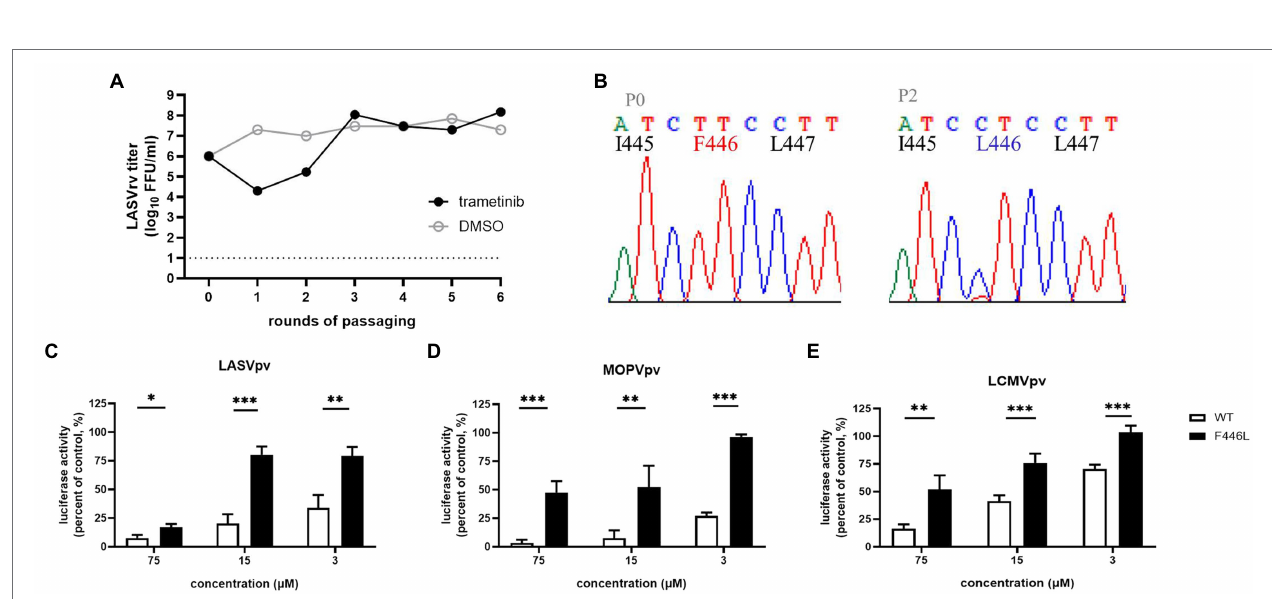
FIGURE 5 | Broad-spectrum antiviral activity of trametinib. (A–H) The inhibition of trametinib against the infection of the pseudotype of mammarenaviruses. (I) Inhibition of trametinib against authentic lymphocytic choriomeningitis virus (LCMV) infection. Vero cells were incubated with trametinib for 1 h, and LCMV Cl 13 (MOI, 0.01) was added into the cells 1 h. Then, the supernatants were replaced with medium containing trametinib. After 24 h, the cell lysates were subjected to real-time (RT) quantitative PCR (qPCR), with the primes of f: 5 ' -AGAATCCAGGTGGTTATTGCC-3 ' and r: 5 ' -GTTGTAGTCAATTAGTCGCAGC-3 ' . Data are presented as means ± SD from 3 to 5 independent experiments.